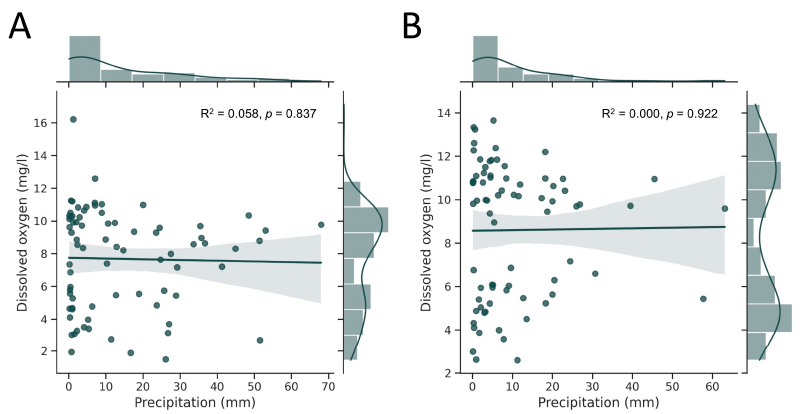
Figure 10. ( A , B ) Regression plot of precipitation and DO in 2017 and 2021, respectively.